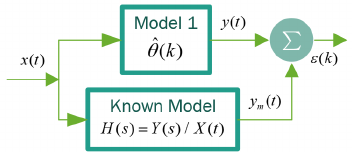
Figure 6. Application Instrumental Variable block diagram (experimental